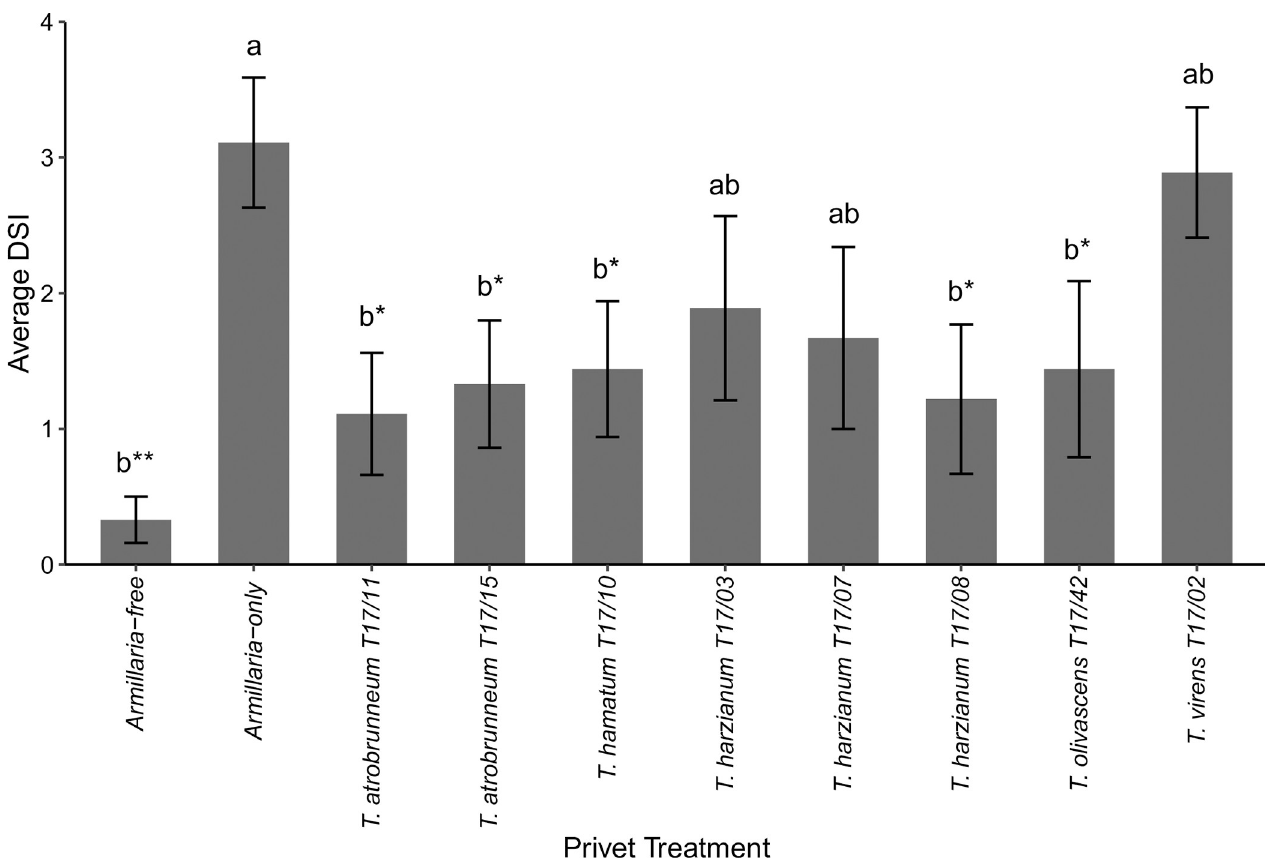
Fig 4. The average disease severity index (DSI) of Armillaria mellea CG440 infection in privet plants after nine months in plants pre-colonised with Trichoderma spp. The error bars represent the standard error of the mean (n = 9). a, b represent statistical groups (Kruskal-Wallis) and the level of significance is indicated as � p < 0.05, �� p < 0.01, ��� p < 0.001.